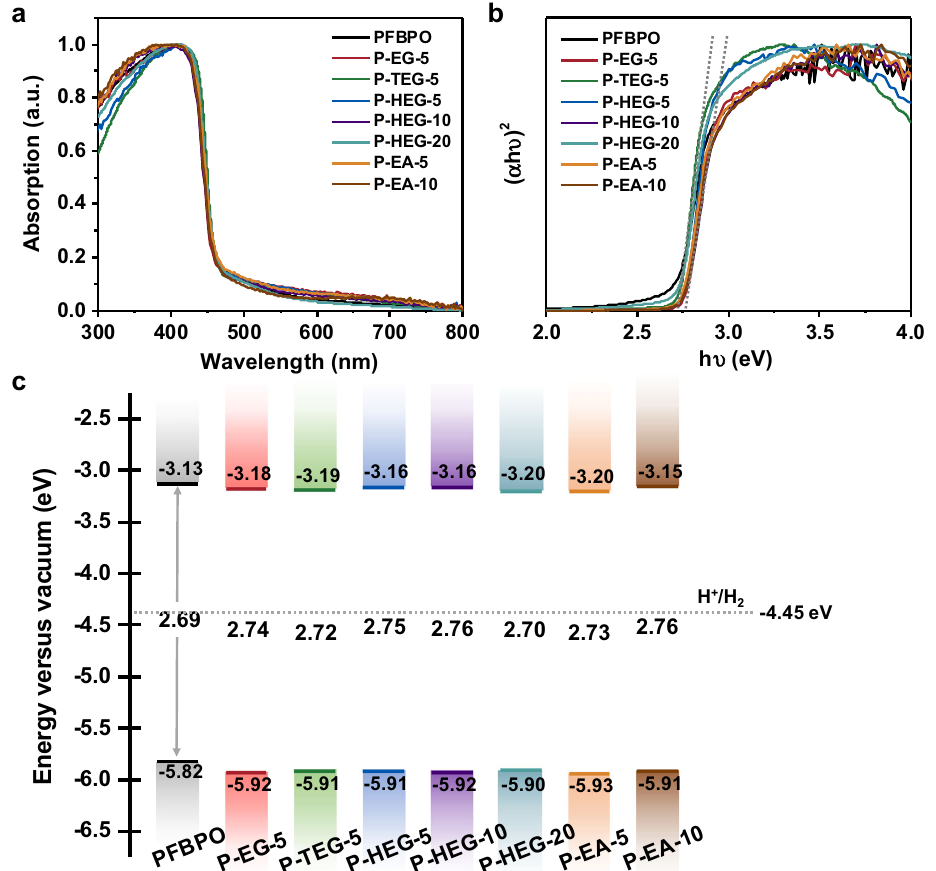
Fig. 2 | Optical properties of polymers. a Solid-state UV-vis diffuse re fl ectance spectra, b Tauc plots, and c energy level diagram of all polymers as measured by PESA in conjunction with Tauc plot. The dashed lines correspond to the proton reduction potential (H + /H 2 ). All energy levels and electrochemical potentials are